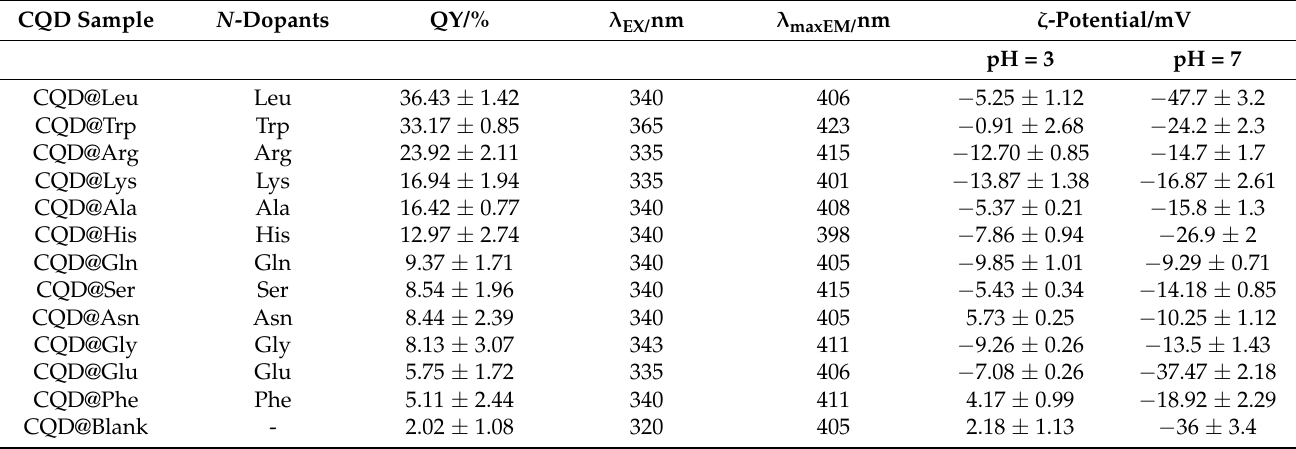
Table 1. Optical characteristics of the CQDs prepared from citric acid analyzed under pH = 3 and pH =